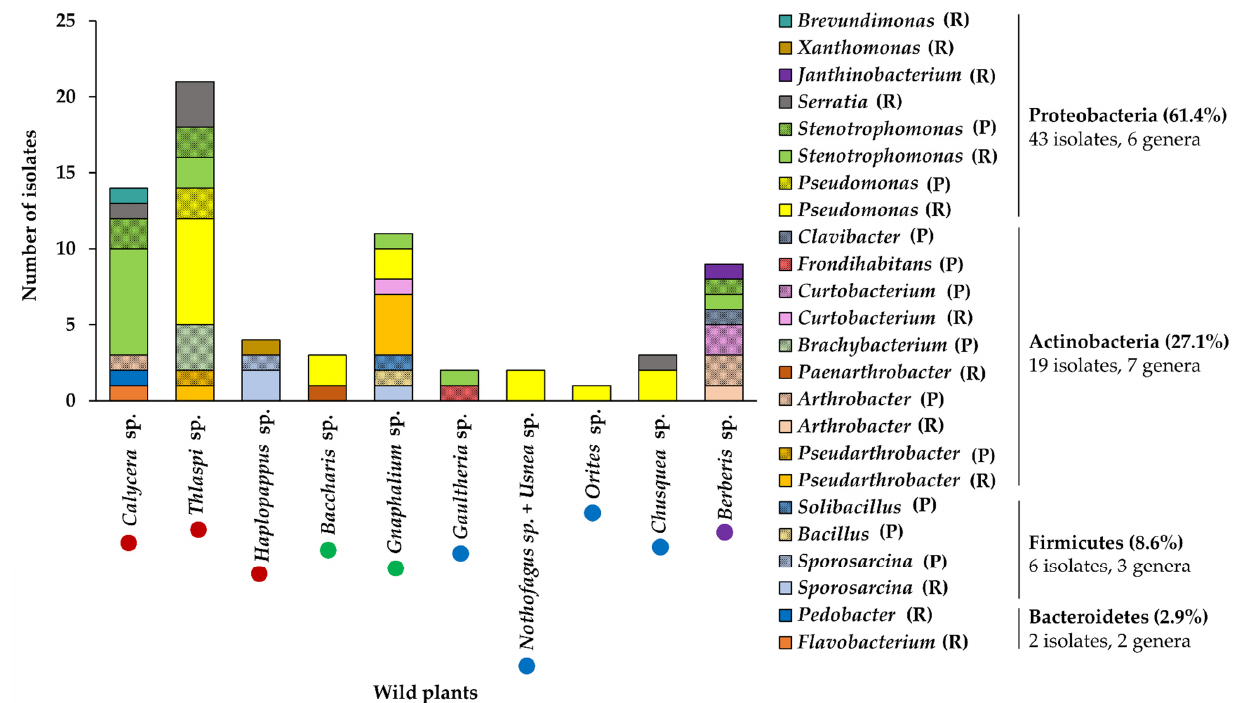
Figure 2. Biodiversity of the selected psychrotolerant bacterial strains from wild plants of Andean and Patagonia areas of Chile. The different genera were represented in solid colors for isolates from rhizosphere (R) and crosshatch colors for isolates from the phyllosphere (P). Circles next to the wild plant genera represent the regions of Chile. Red circles, Valparaíso Region; green circles, Libertador General Bernardo O’Higgins Region; blue circles, Ñuble Region; and purple circle, Magallanes and Chilean Antarctica Region.